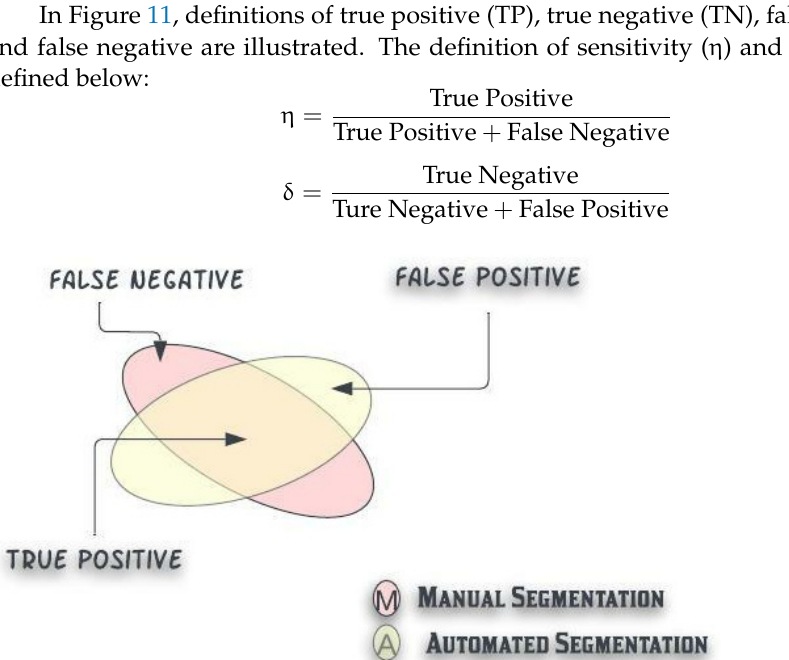
Figure 11. Defining the evaluation standard: True negative, False Positive, True positive in automated vs. manual segmentation.